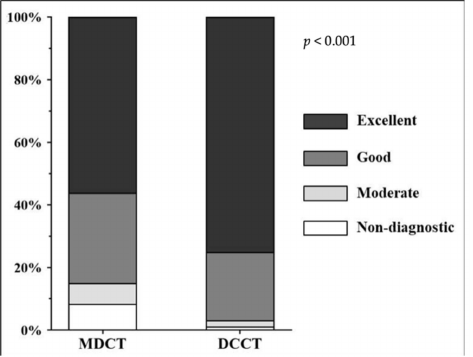
Figure 3. Proportion of coronary segments with excellent, good, moderate and non-diagnostic image quality in the MDCT and DCCT subgroups. MDCT, multidetector CT; DCCT, dedicated cardiac CT.